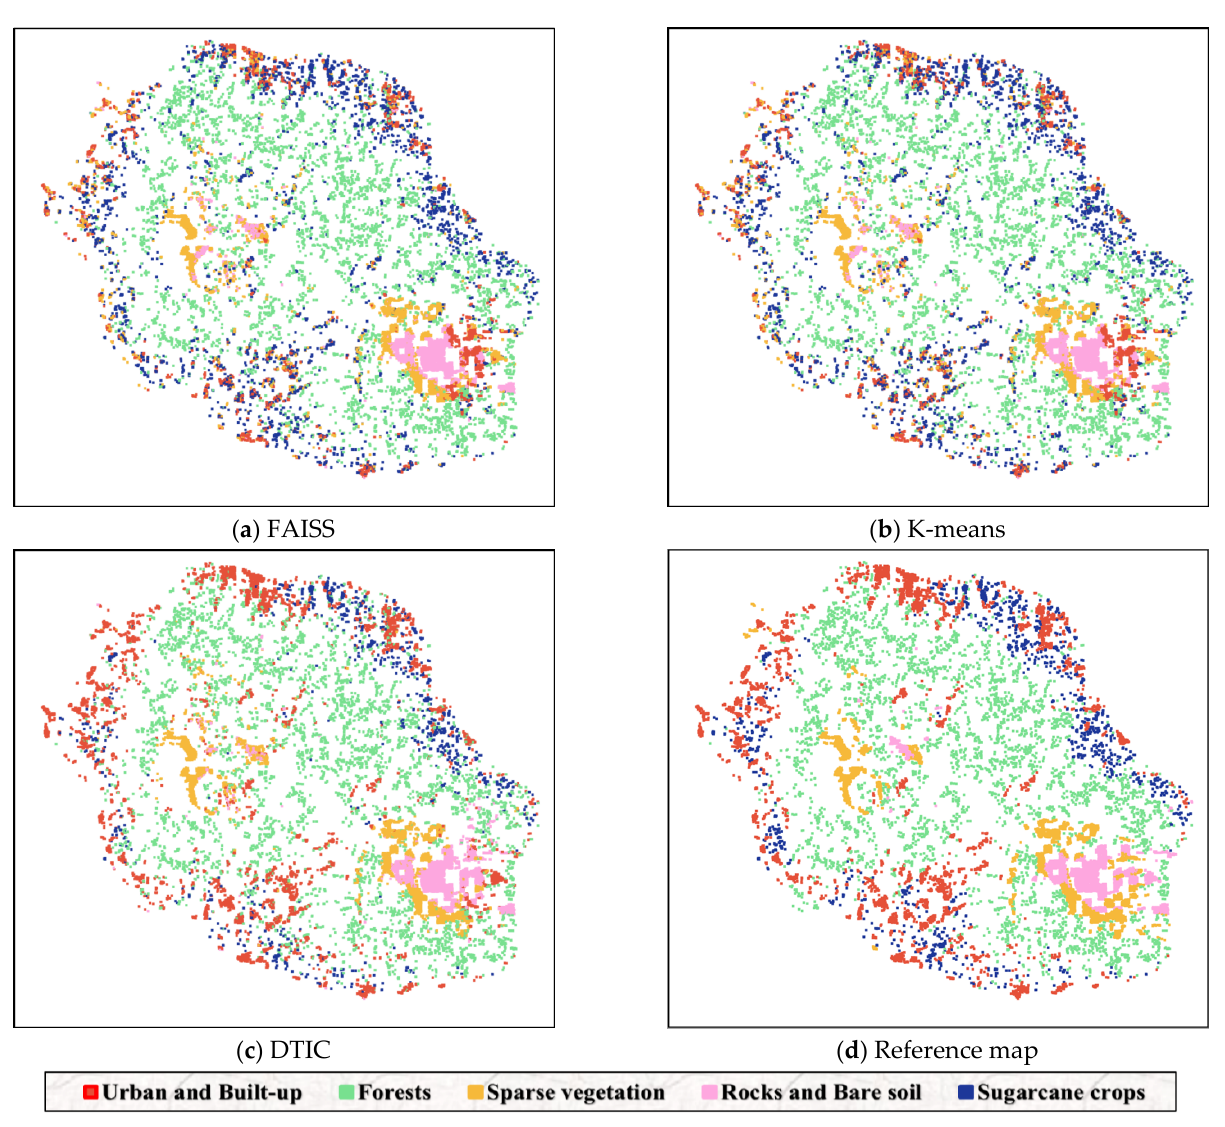
Figure 10. Clustering maps of the Reunion Island Dataset produced by using different methods with averaged initial cluster centers. ( a ) FAISS; ( b ) K-means; ( c ) DTIC; ( d ) reference map.